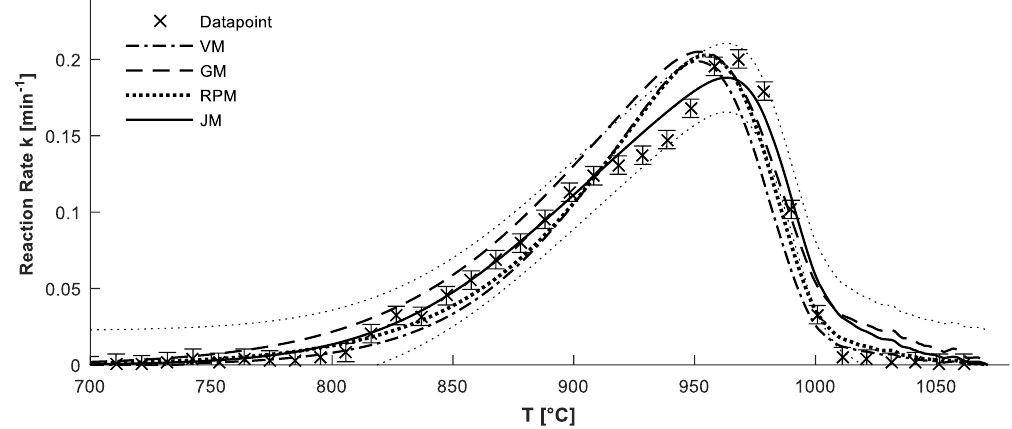
Figure 5. Measurement and L–H model results for CO₂ gasification in configuration No. 6 (33 mL/min / min CO); 95% confidence interval for JM is marked with a thin dotted CO₂, 20 mL/min CO); 95% confidence interval for JM is marked with a thin dotted line. CO 2 , 20 mL